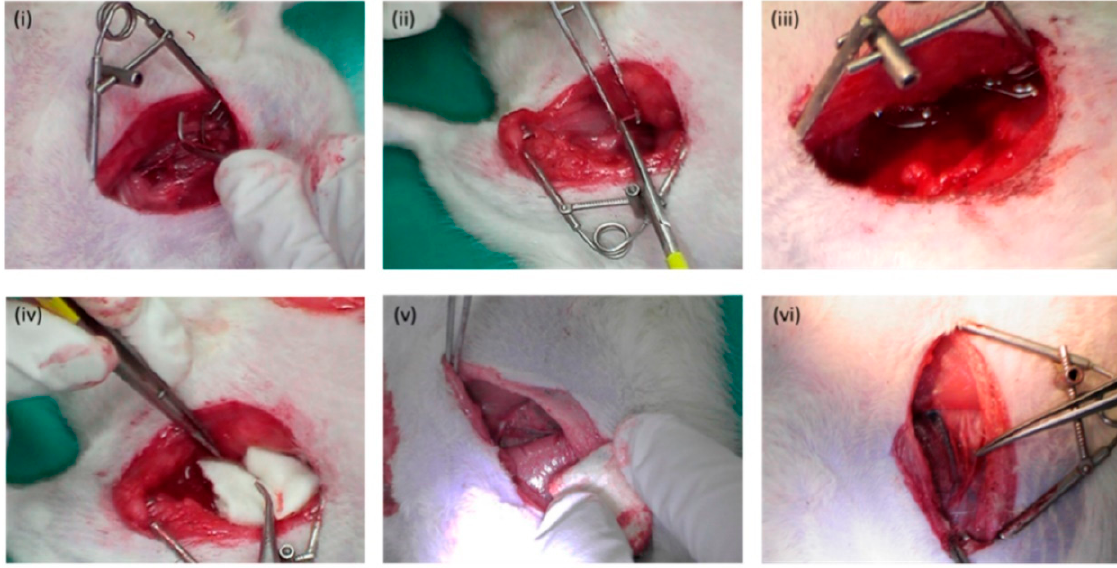
Figure 2. The hemostatic effect of the dressing with a rat femoral artery hemorrhage model. ( i – iii ) for compression hemostasis; ( iv – vi ) for CS dressing hemostasis [67]. Copyright 2019 Creative Com- mon.